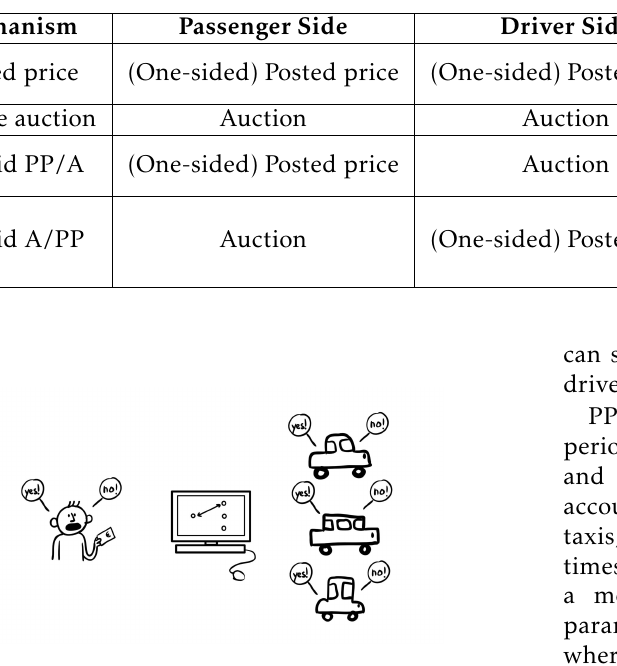
Figure 1. Illustrationof the posted-pricemechanism.In posted- price mechanismsa single passenger is o˙ered a price by the providerand is able to accept or reject the o˙er. A numberof driversare theno˙eredthe passenger’s journeyanda commission.